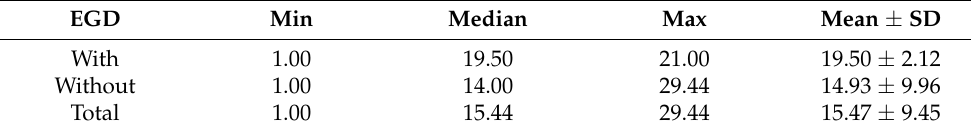
Table 5. Days to CAD recurrence in one month.